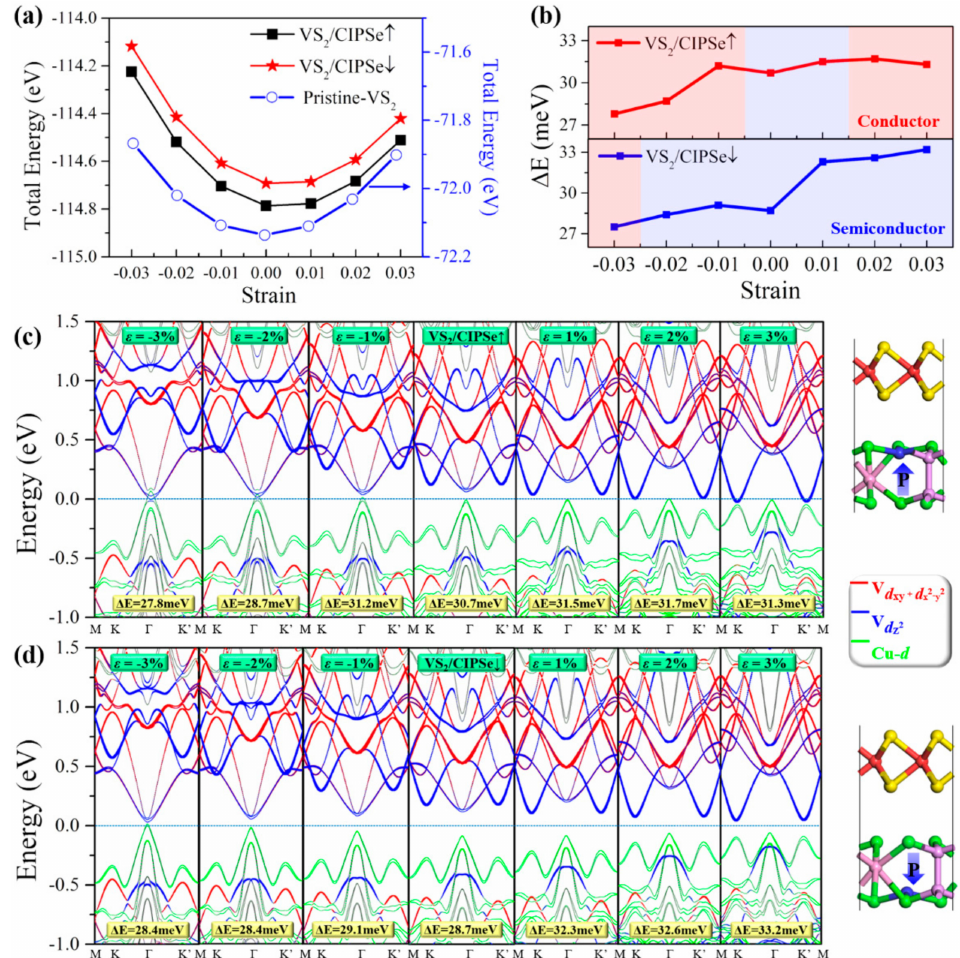
Figure 4. In–plain biaxial strain effect on valley splitting and band structures with SOC of VS 2 /CIPSe heterostructures. ( a ) relationships between total energies and biaxial strains (black, red, and blue curves are for VS 2 /CIPSe ↑ , VS 2 /CIPSe ↓ and pristine VS 2 , respectively); ( b ) valley splitting energies ( ∆ E) under biaxial strains for VS 2 /CIPSe ↑ , VS 2 /CIPSe ↓ , red and blue area indicate conductor and semiconductor behaviors. ( c , d ) valley splitting and band structures with SOC of VS 2 /CIPSe het- erostructures under biaxial strains with upward ( c ) and downward ( d ) ferroelectric polarization. The red, blue, and green lines denote the contributions from V– d xy + d x 2 − y 2 , V– d z 2 and Cu– d orbitals, respectively. The Fermi level is set to